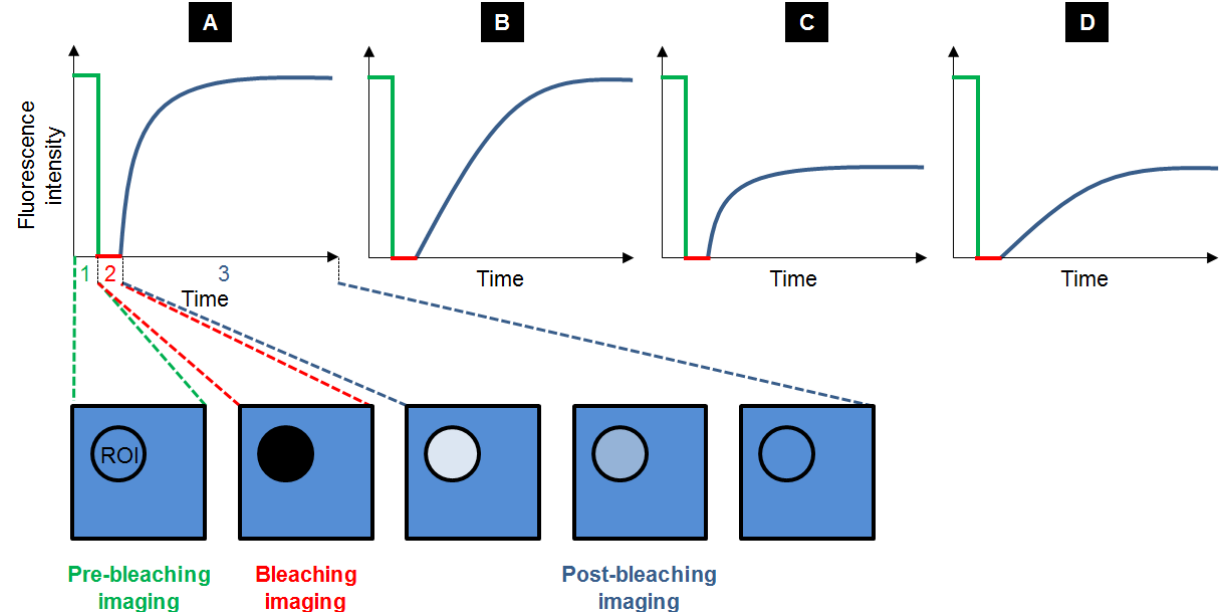
Figure 3. Typical recovery curves obtained after FRAP experiments: the fluorescence intensity is measured before (step 1, in green), during (step 2, in red) and after photobleaching (step 3, in blue), while equilibrium is taking place. Several cases can be observed depending on the velocity and the amplitude of the recovery. Recovery can be fast with a maximal recovery ( A ), or slow with a maximal recovery ( B ). It can also be fast with a limited recovery ( C ) and even slow with a limited recovery ( D